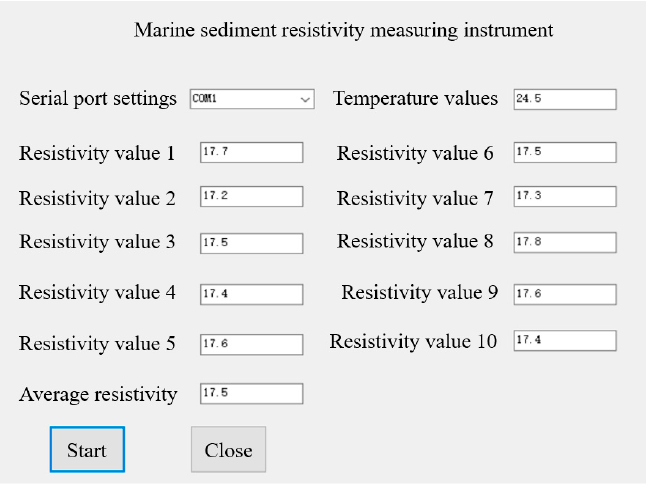
Figure 16. Upper machine software interface of the marine sediment resistivity measuring instru- ment.